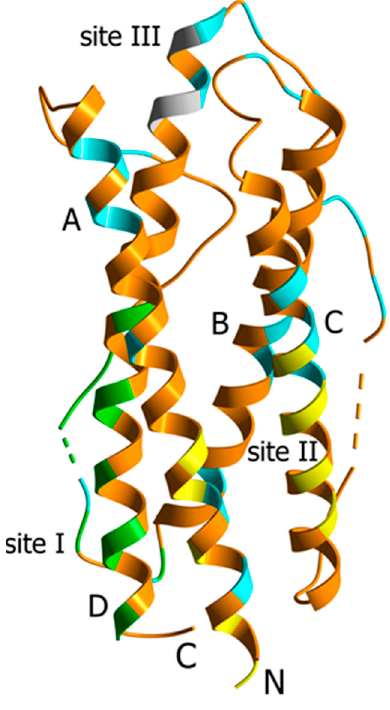
Figure 1. Crystal structure of human IL-11 (PDB entry 4MHL [20]). α -Helices A to D are labelled. Dashed lines mark the non-resolved regions. The residues comprising the proposed sites for IL-11 interaction with IL-11R α (site I, green) and gp130 (site II, yellow; site III, grey) receptors [20] are indicated. The residues not conserved in either macaque or mouse IL-11 are shown in cyan (see Figure S1).